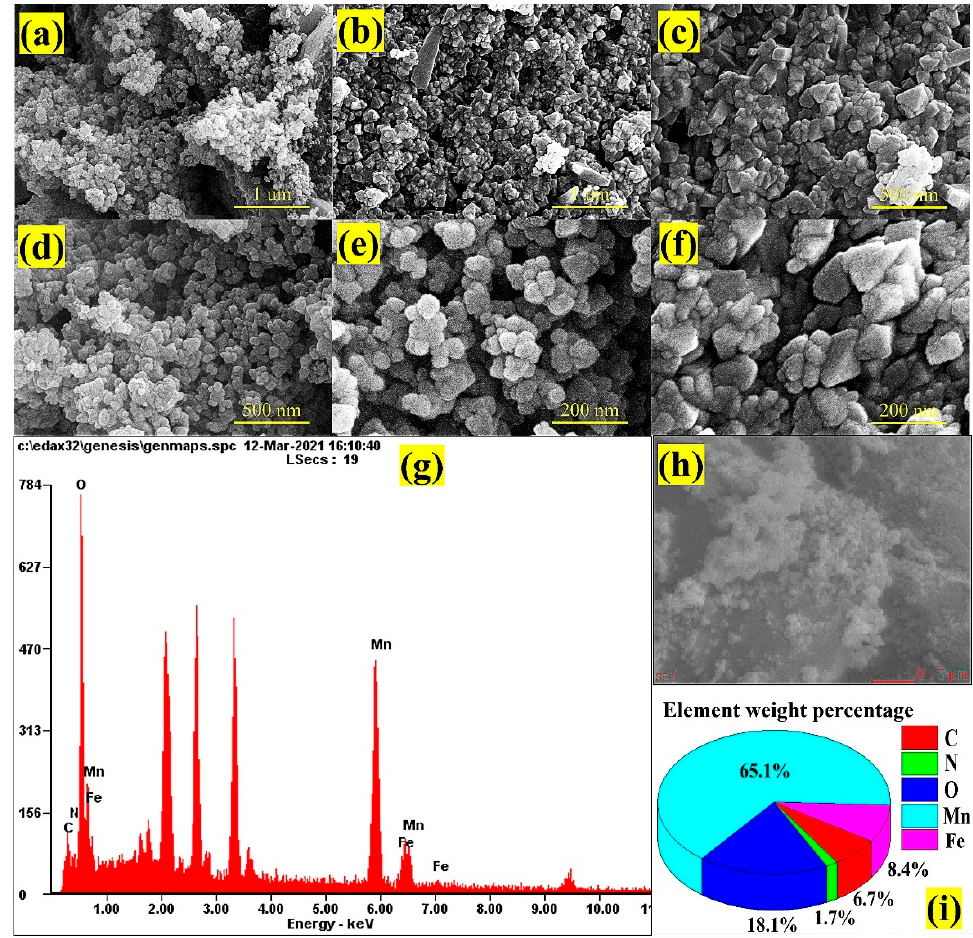
Figure 4. ( a – f ) High-resolution SEM images of NGO@MnO 2 /PPy under different magnification lev- els. ( g – i ) EDX